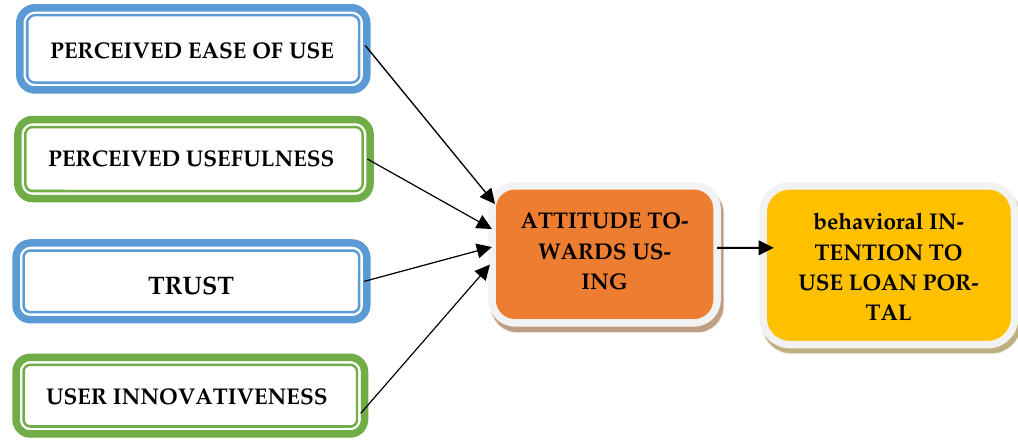
Figure 2. Conceptual framework.